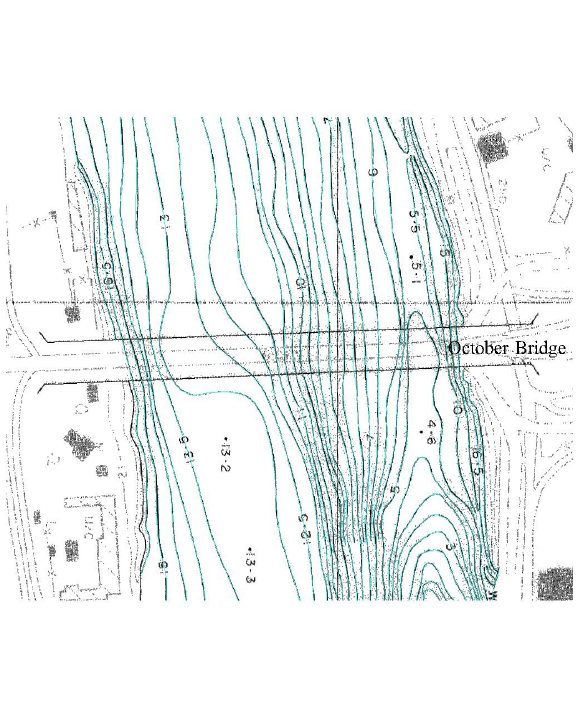
Figure 7. A contour map for River Nile bed at the year 1982